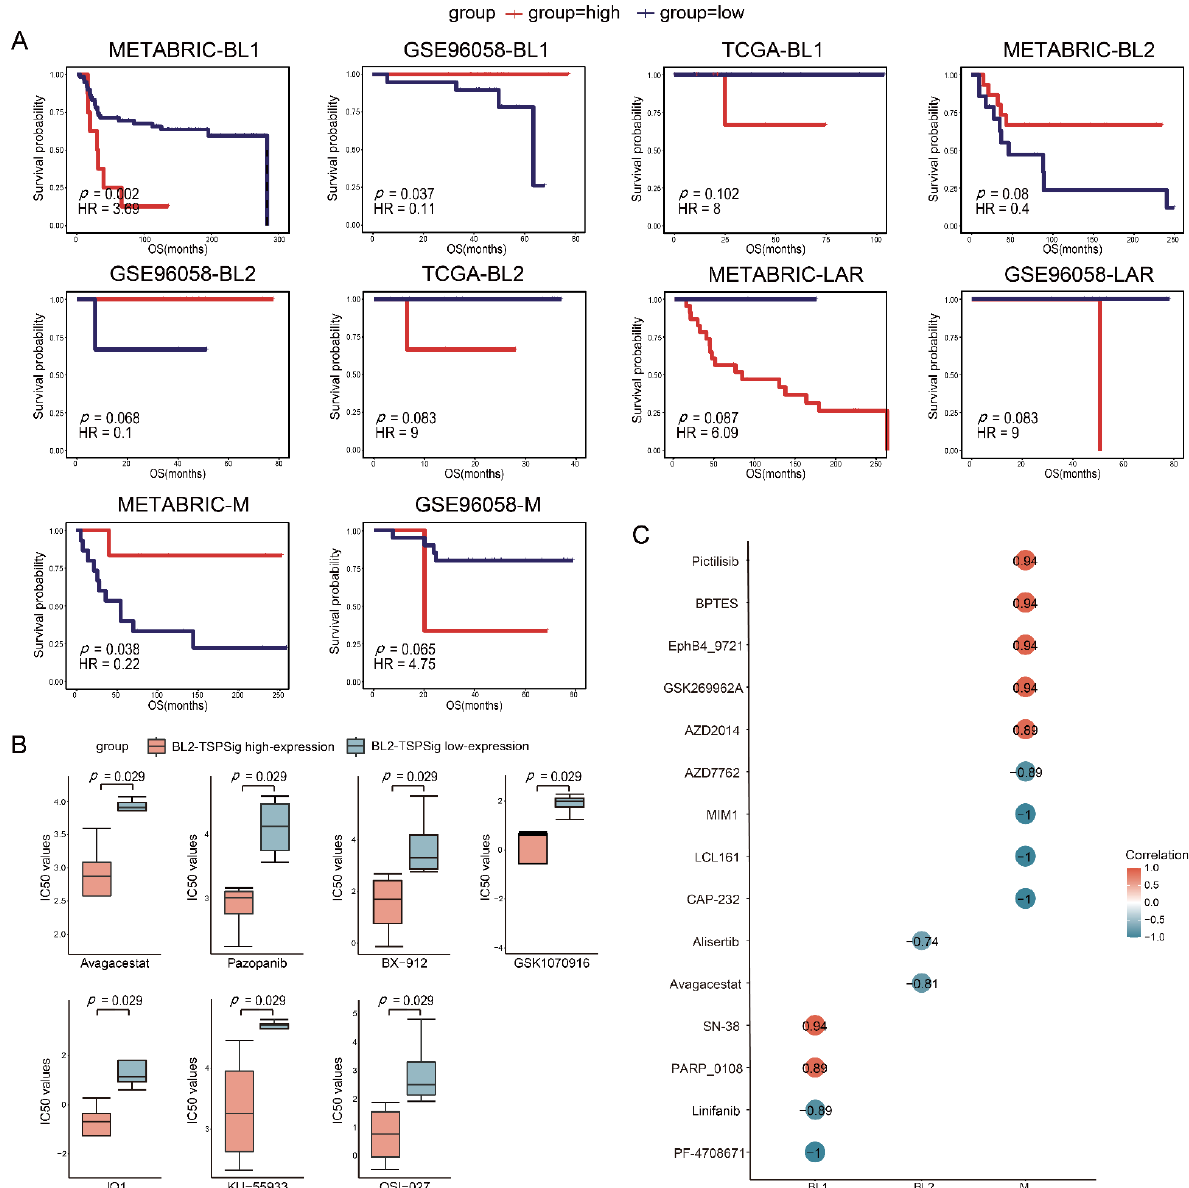
Figure 5. Estimation of the predictive powers of TSPSigs and the relationships between the TSPSigs expressions and drug sensitivities. ( A ) Kaplan-Meier survival curves of the OS between high-risk and low-risk patients with chemotherapy of each TNBC subtype in three validation datasets (METABRIC, GSE96058, and TCGA). ( B ) Differences in the IC50 values of the BL2-subtype cell lines treated with seven drug components between the BL2-TSPSig high- and low-expression groups. ( C ) Correlations between each TSPSig expression level and drug sensitivity (IC50). A positive (or negative) correlation means that the high expression of TSPSig was resistant (or sensitive) to the drug.